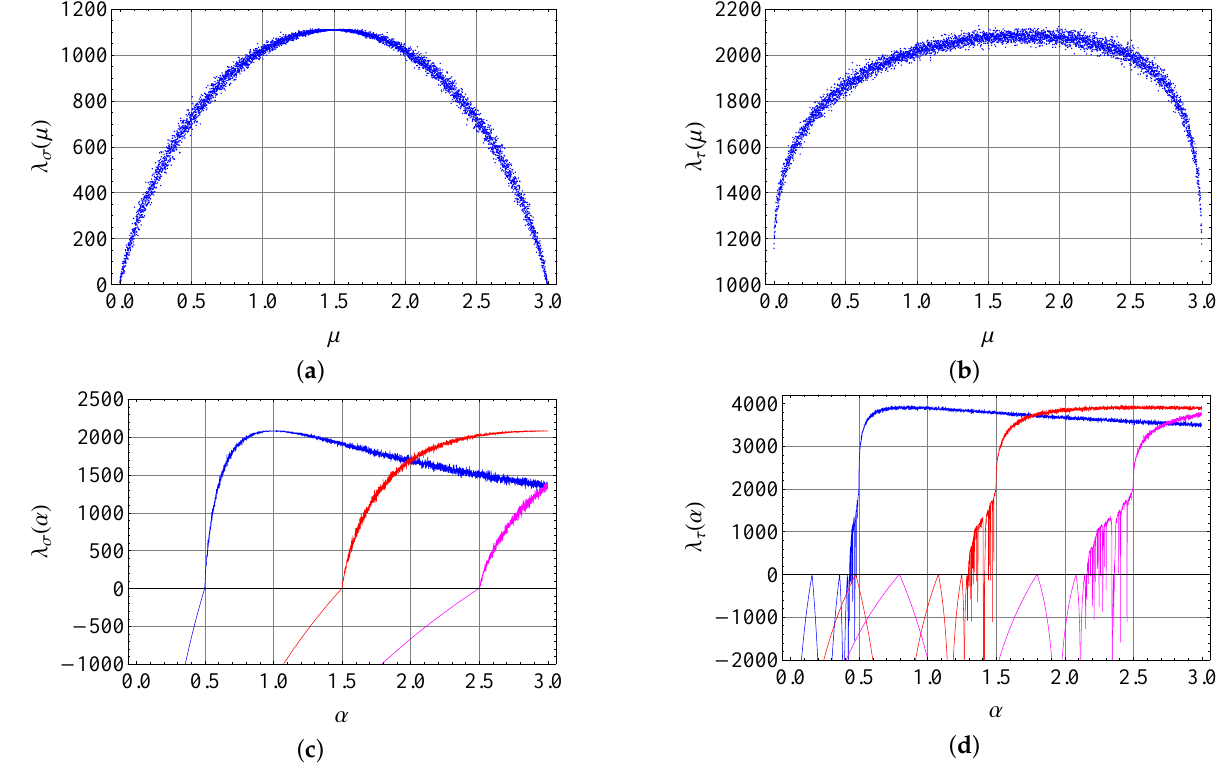
Figure 6. ( a ) λ σ for the STM when α = 3.0 and µ ∈ (0, α ), ( b ) λ τ for the FC when α = 3.0 and µ ∈ (0, α ), ( c ) λ σ for the STM when α ∈ (0, 3.0) and µ = 0.3 (blue line), µ = 1.5 (red line), and µ = 2.5 (magenta line), and ( d ) λ τ for the FC when α ∈ (0, 3.0) and µ = 0.3 (blue line), µ = 1.5 (red line), and µ = 2.5 (magenta